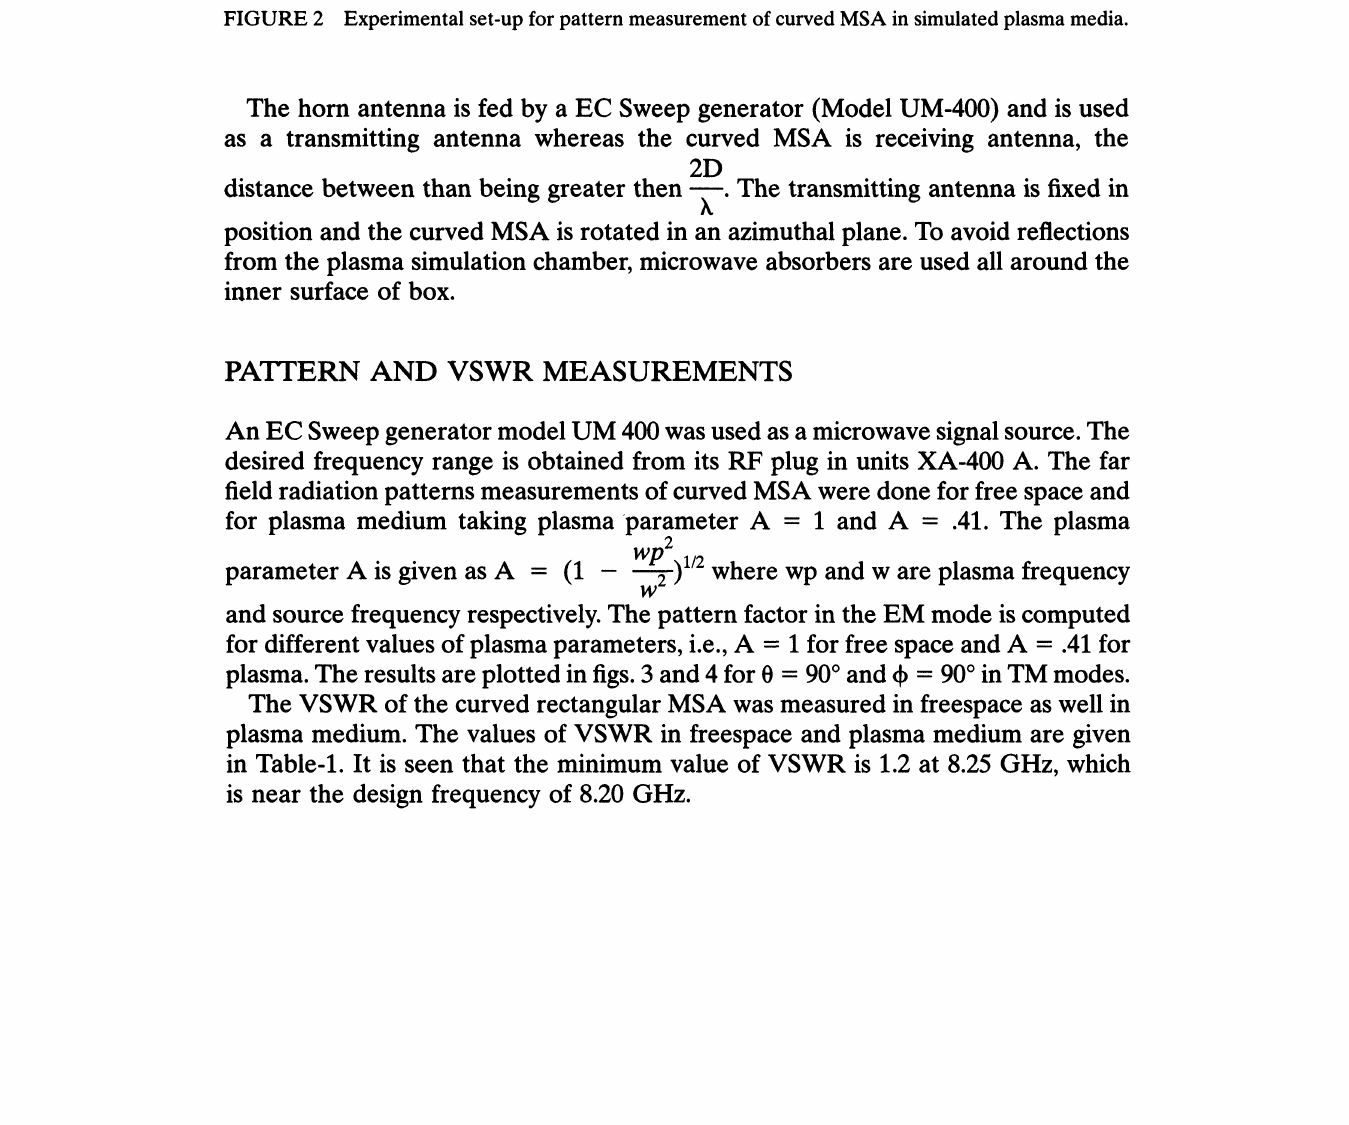
FIGURE 2 Experimental set-up for pattern measurement of curved MSA in simulated plasma